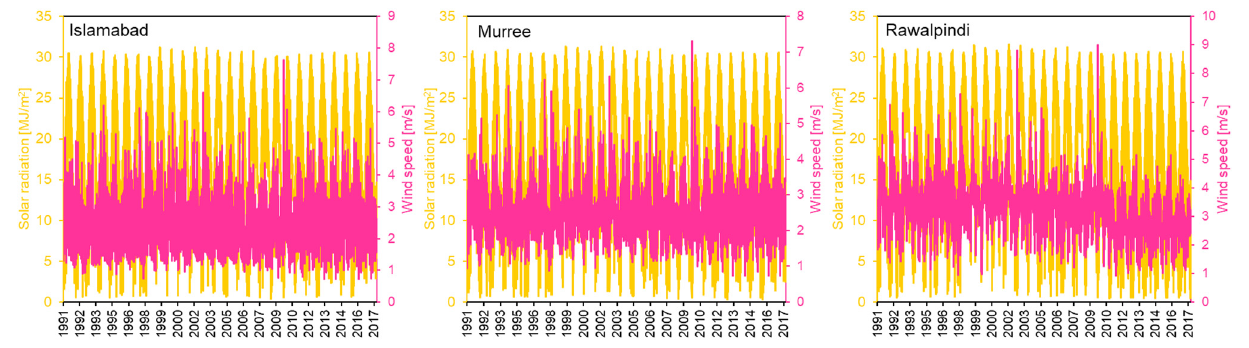
Figure A2. Temporal solar radiation and wind speed profiles of baseline period for Islamabad, Murree, and Rawalpindi.